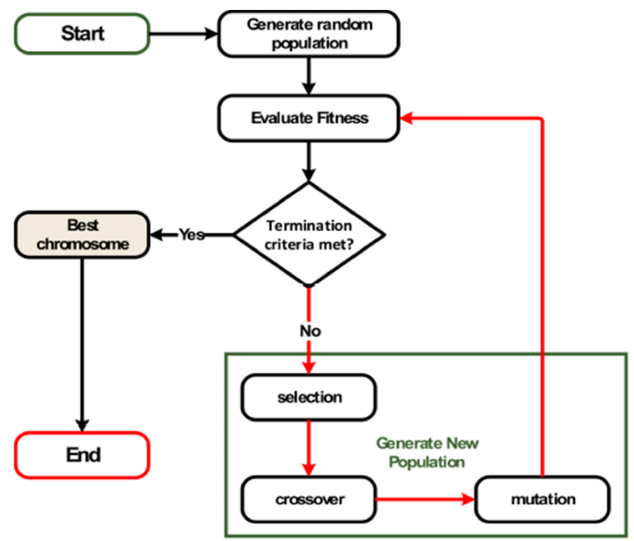
Figure 2. Genetic algorithm simple